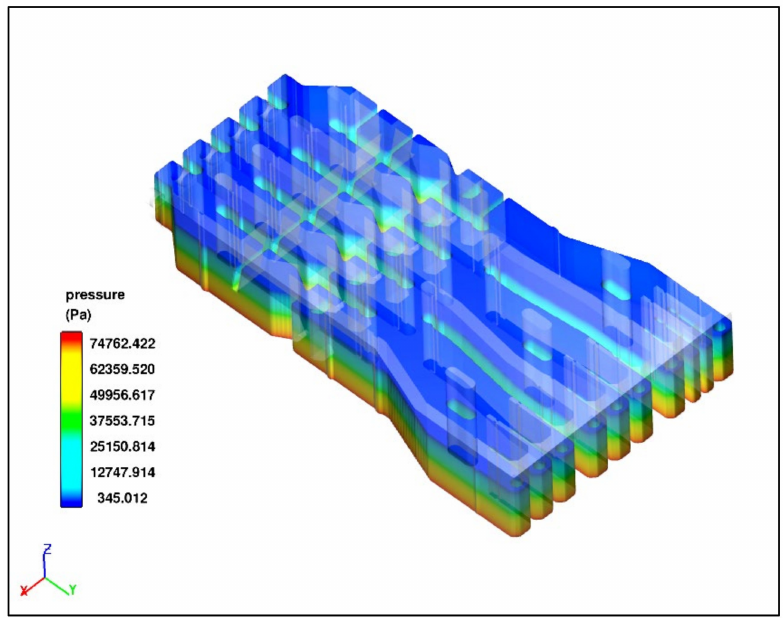
Figure 15. Pressure contours at the basin for scenario V—3D